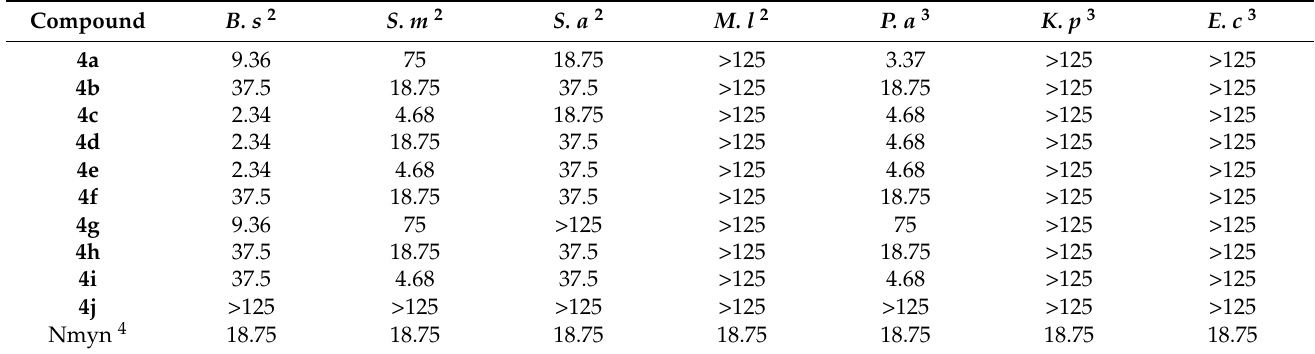
Table 2. Antibacterial activities of oxazolidinone-amide conjugates ( 4a–j ) 1